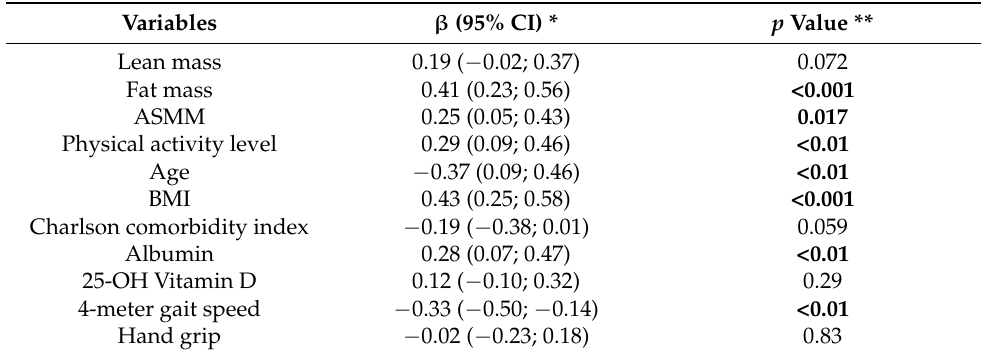
Table 2. Univariable analysis of factors associated with the femoral neck T-score in women patients aged ≥ 75 years.